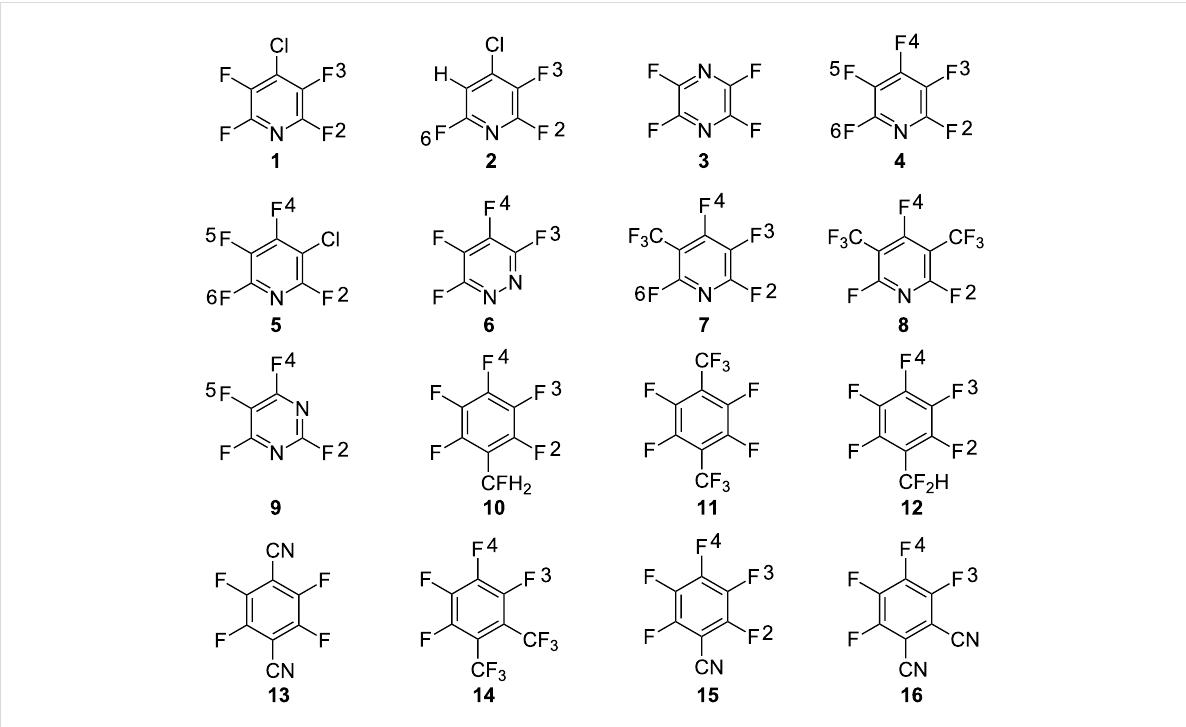
Figure 1: The structures investigated in the amination of heterocyclic and carbocyclic derivatives (series A and B, respectively) and the numbering of their